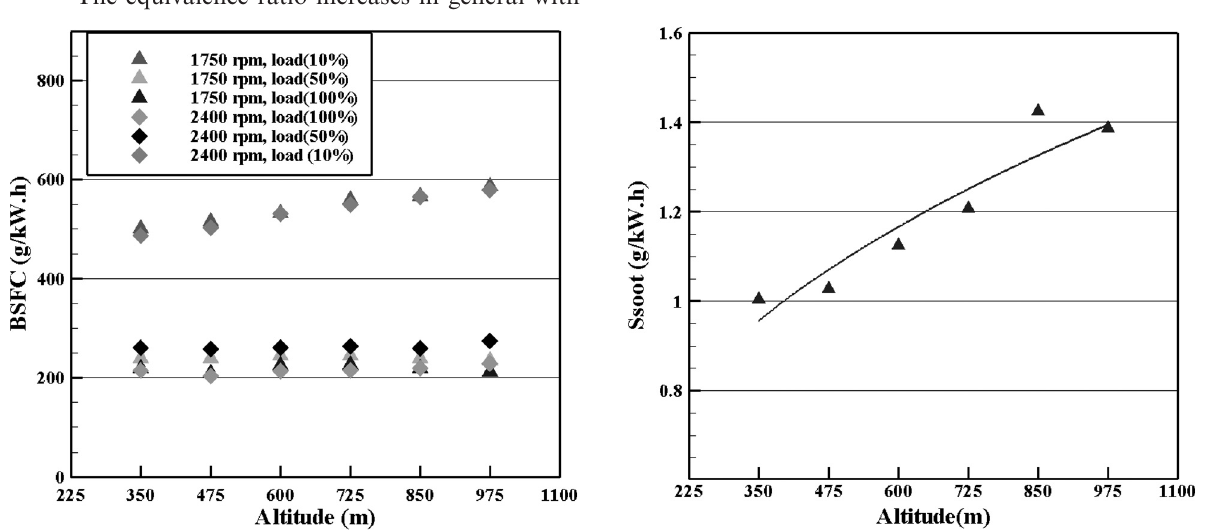
Fig. 6. Effect of altitude on BSFC Fig. 7. Effect of altitude on soot emission